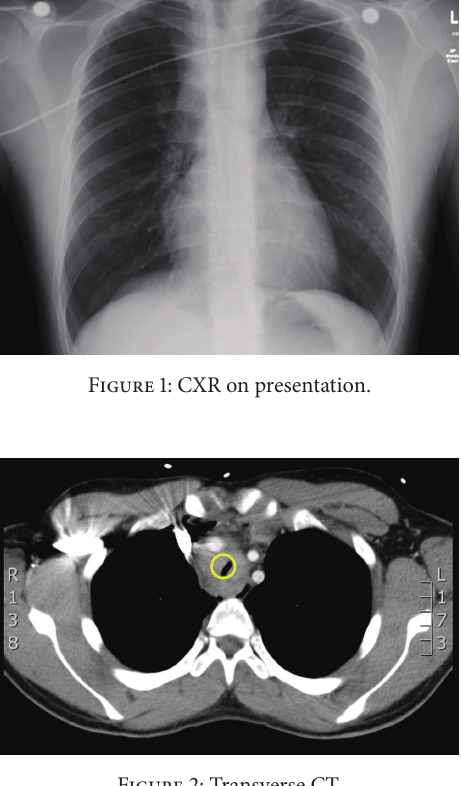
Figure 2: Transverse